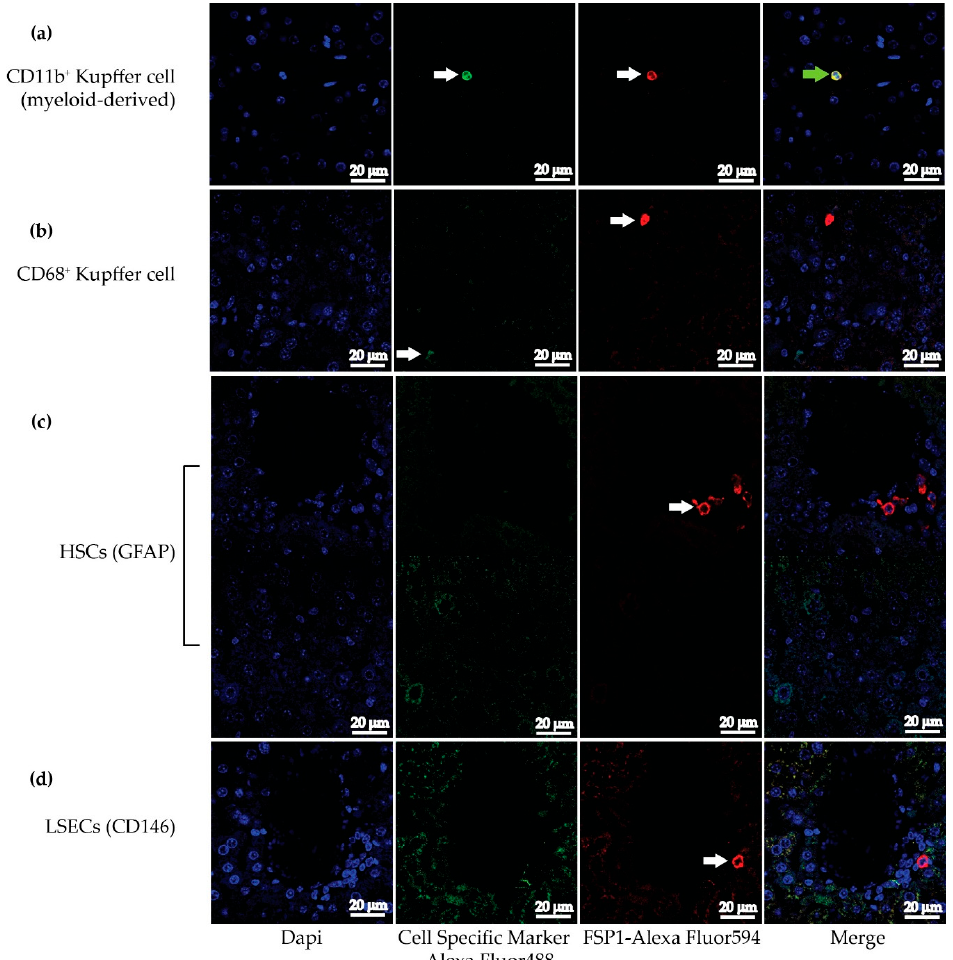
Figure 1. Double immunofluorescence staining in Fibroblast-specific protein 1 (FSP1)cre- Pparb / d − / − liver for Glial fibrillary acidic protein (GFAP), CD146, CD68 or CD11b with FSP1. ( a ) CD11b-expressing liver resident macrophages express FSP1. ( b ) CD68-expressing Kupffer cells do not express FSP1. ( c ) GFAP-expressing hepatic stellate cells (HSCs) do not express FSP1. ( d ) CD146-expressing LSECs do not express FSP1. Arrows indicate staining; the green arrow indicates positive co-staining of CD11b and FSP1.